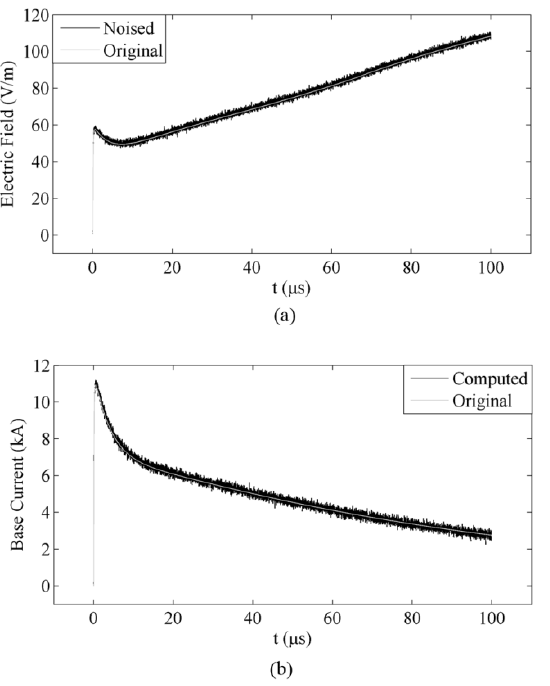
Figure 5. Signal deconvolution with presence of noise: ( a ) electric field with 2 V/m Gaussian noise and ( b ) the base current response for r = 5 km. Notice the original signal without noise was accurately covered by the noised signal in this